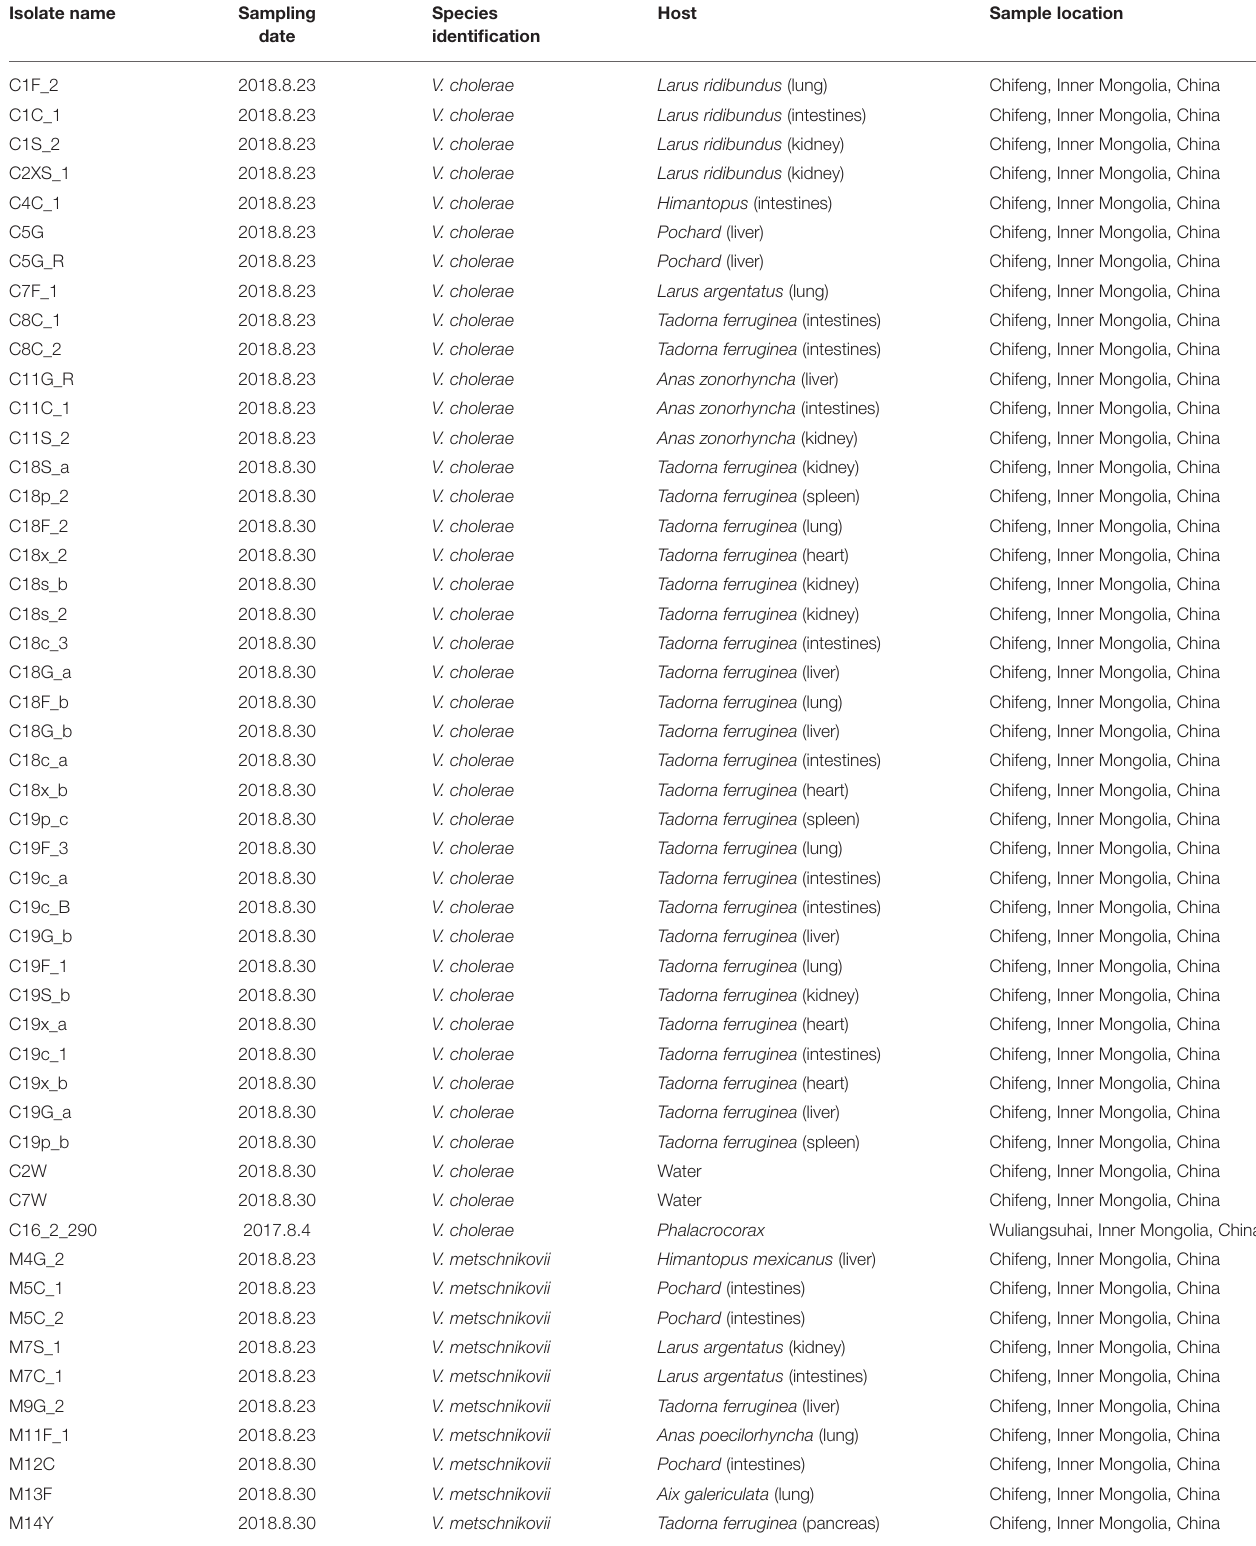
TABLE 1 | Characteristics of Vibrio cholerae and Vibrio metschnikovii isolates identified in migratory birds. Isolate